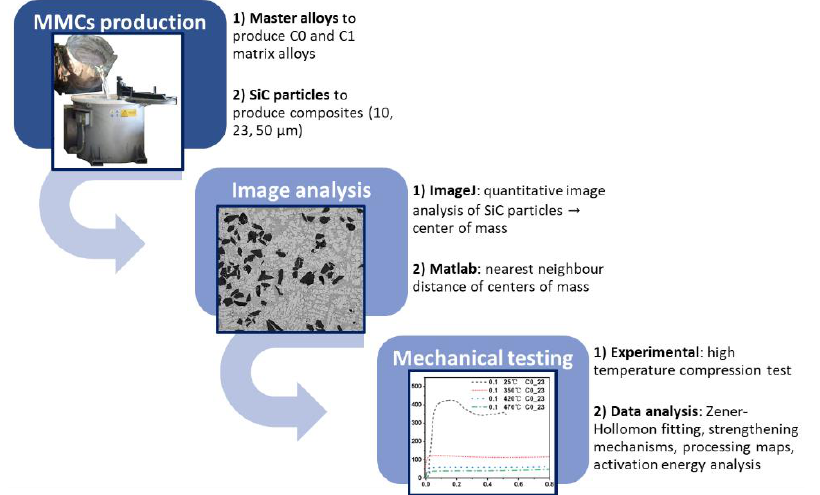
Figure A1. Schematic description of the experimental procedure described in Section 2.